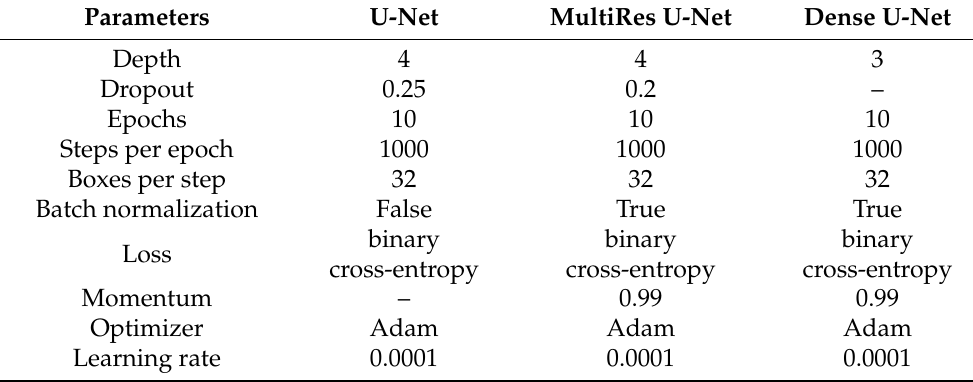
Table 2. Model parameters on